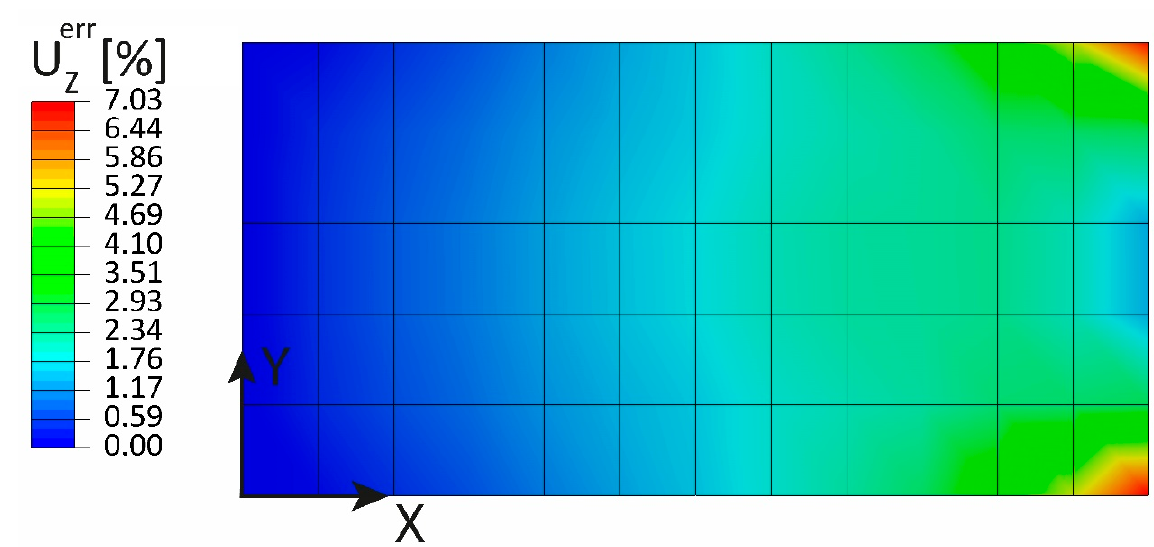
Figure 16 . Uniform pressure: percentage error of the 𝑈 (cid:3027) displacement. Figure 16. Uniform pressure: percentage error of the U